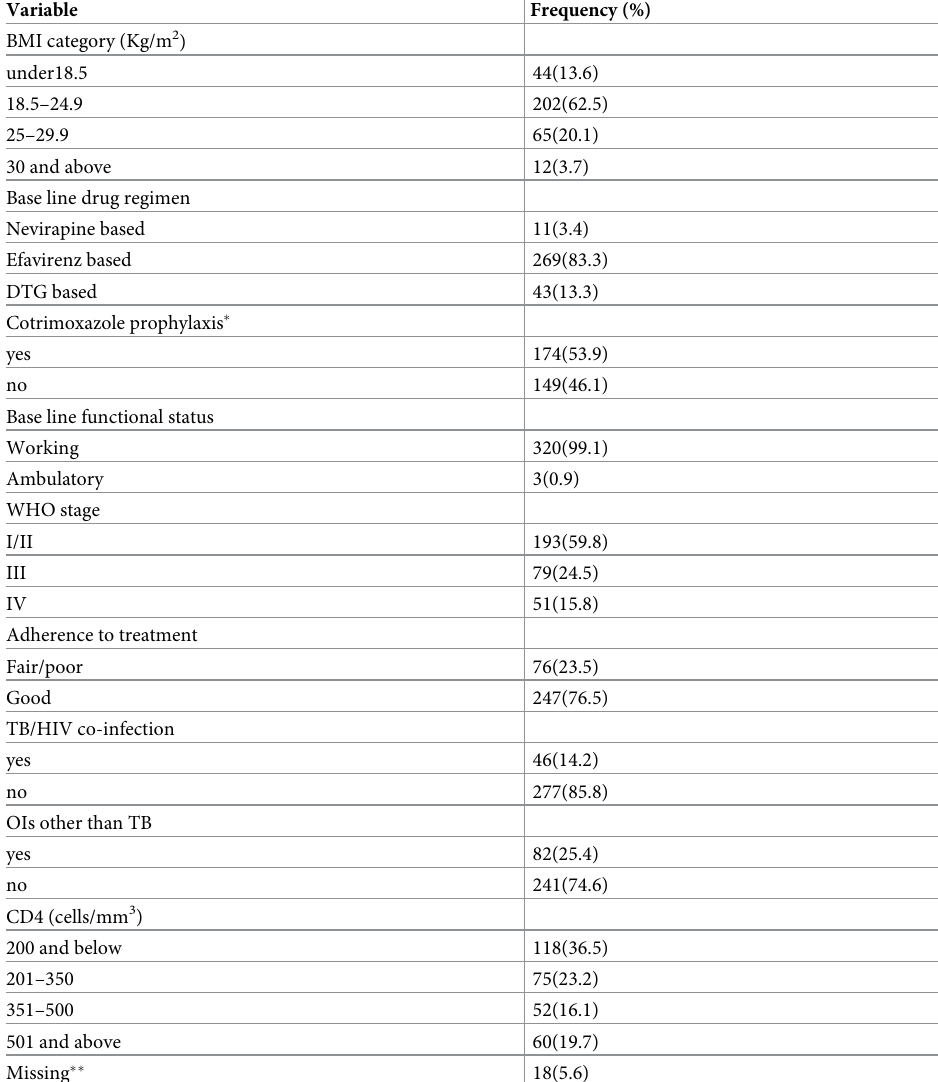
Table 2. Baseline clinical and antiretroviral medication-related information among adult HIV patients on first- line ART in St. Paul’s hospital millennium medical college in Addis Ababa, Ethiopia from July 2016 to December 2020 (N =